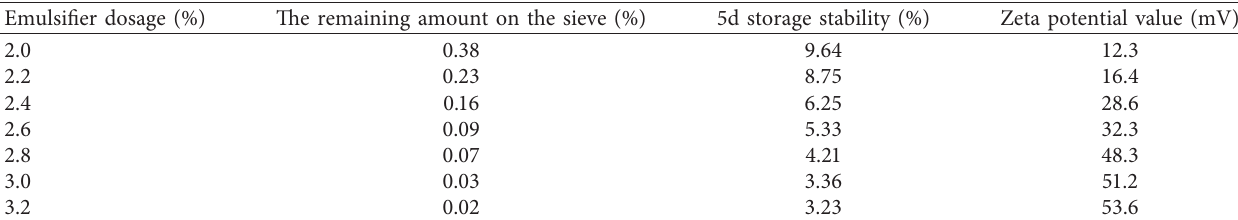
Table 3: Influence of the amount of the anionic emulsifier on the performance of